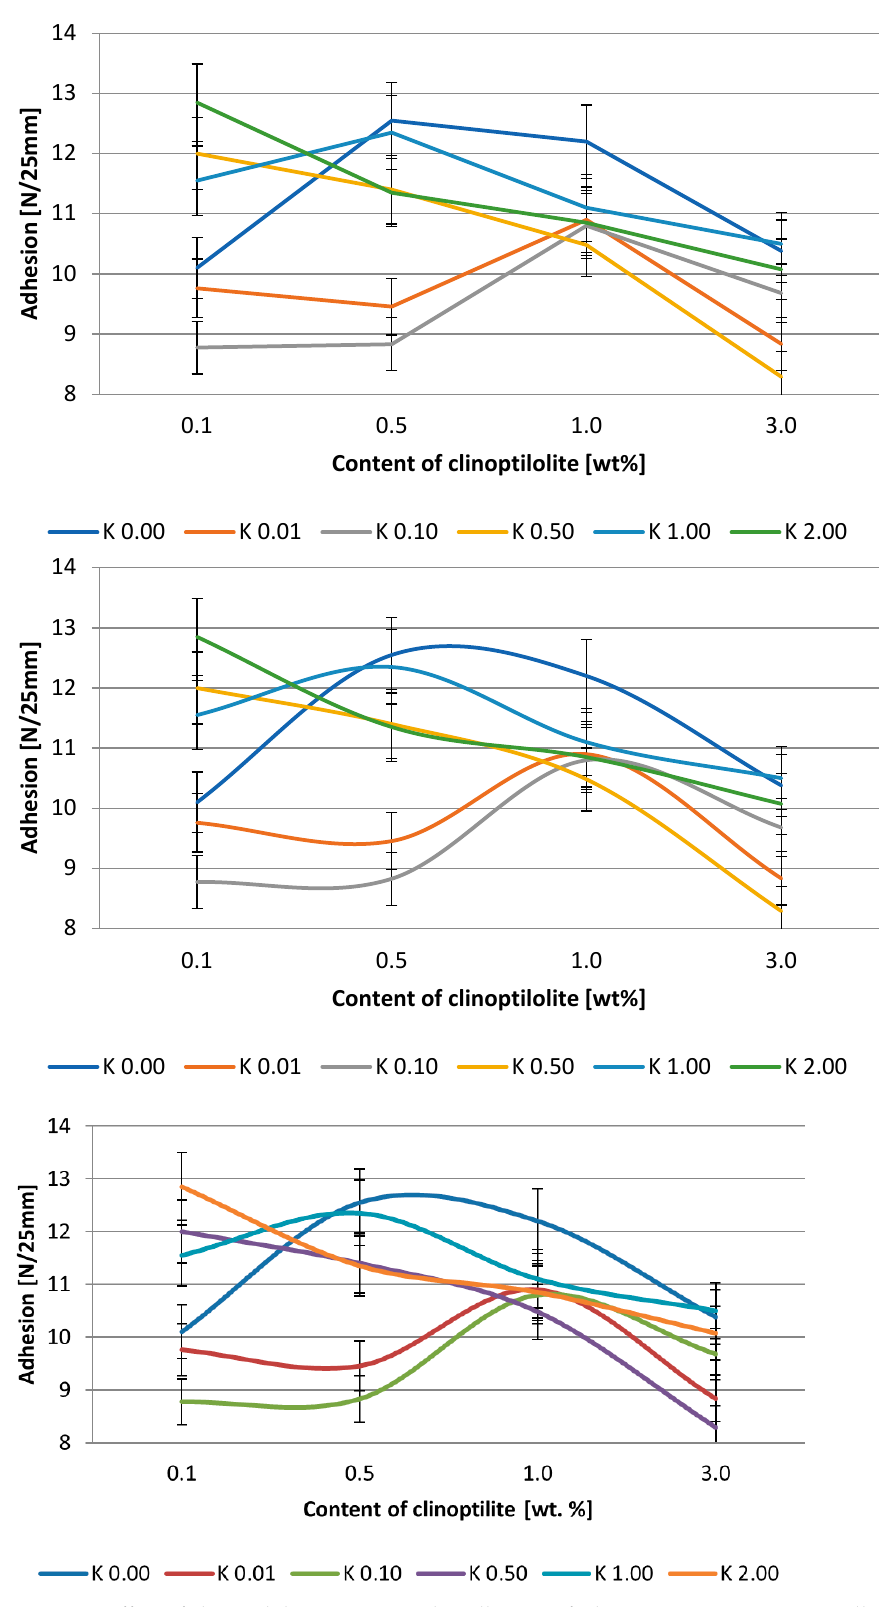
Figure 3. Effect of clinoptilolite content on the adhesion of silicone pressure-sensitive adhesives based on Q2-7358 resin.